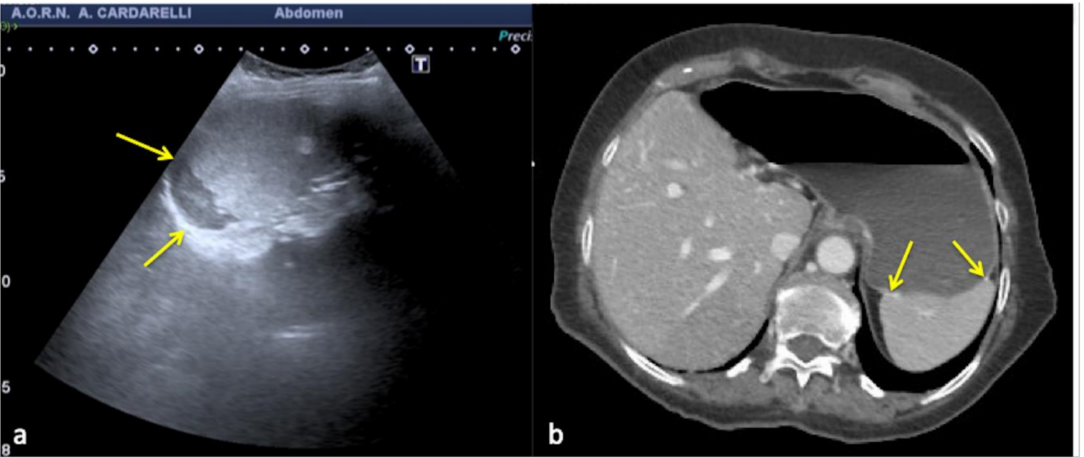
Figure 17. Transverse US image of the left hypochondrium ( a ) shows a large hypoechoic area misinterpreted as splenic hematoma (arrows) in a 31-year-old woman investigated for trauma. On CT scan ( b ) it appears to be a gastric fundus distended by fluid (arrows).